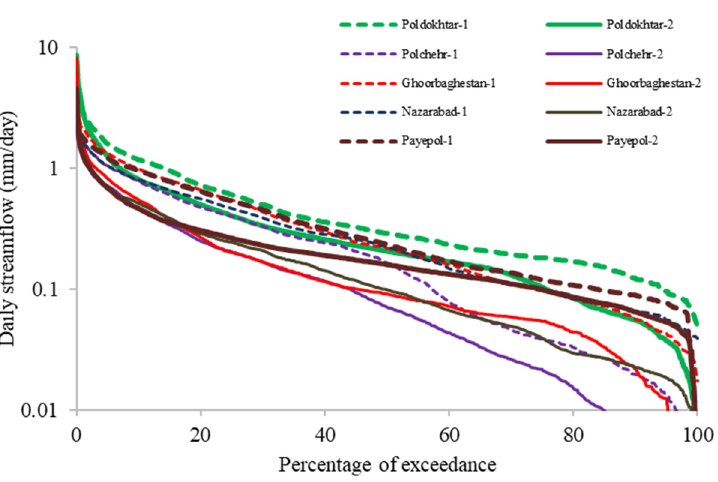
Figure 7. FDCs of the studied sub-basins for the pre-change (1) and post-change (2) periods. Whilst the findings of this study confirm streamflow reduction in all sub-basins, a closer look at the flow duration curve (FDC) reveals a significant reduction in both high flow rates, i.e., streamflow with the exceedance probability of 5% (Q 5 ), and low flow rates, i.e., streamflow with the exceedance probability of 95% (Q 95 ) (Figure 7). For instance, the mean daily streamflow decreased by one-third during 50% of the study period in the Payepol station (Figure 7). The mean monthly flow in the sub-basins also experienced a major reduction for all months (Figure 8), with the exception of the Payepol station, in which the streamflow showed an increase in the summer months (June through -August) during the post-change period. This might be the result of river flow regulation due to the times of abundance, is released in the summer season;, therefore, an increase in summer pre- and post-change periods, during late autumn and winter (October through